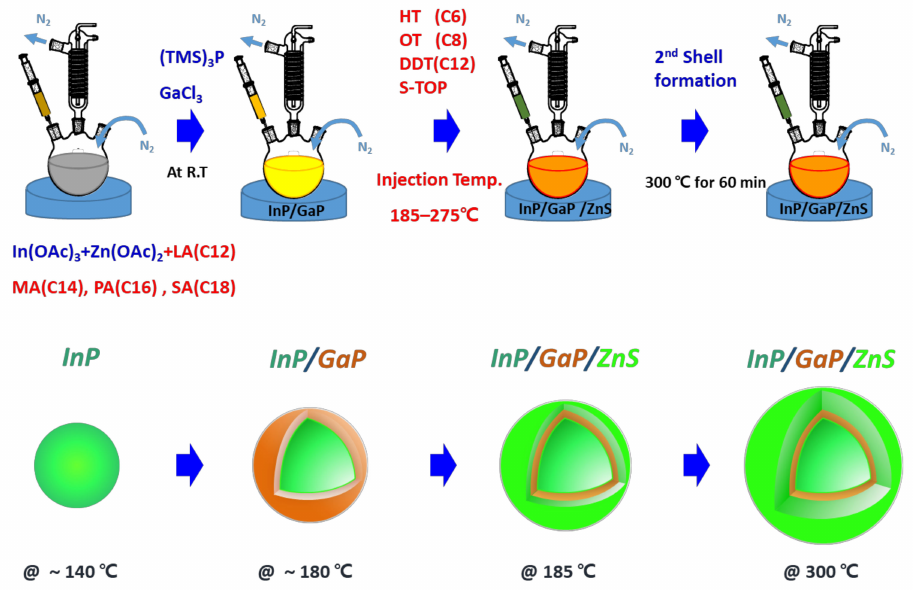
Figure 1. The schematic of the reaction scheme is presented in the top panel. The expected quantum dot (QD) structure at each reaction step is shown in the panel